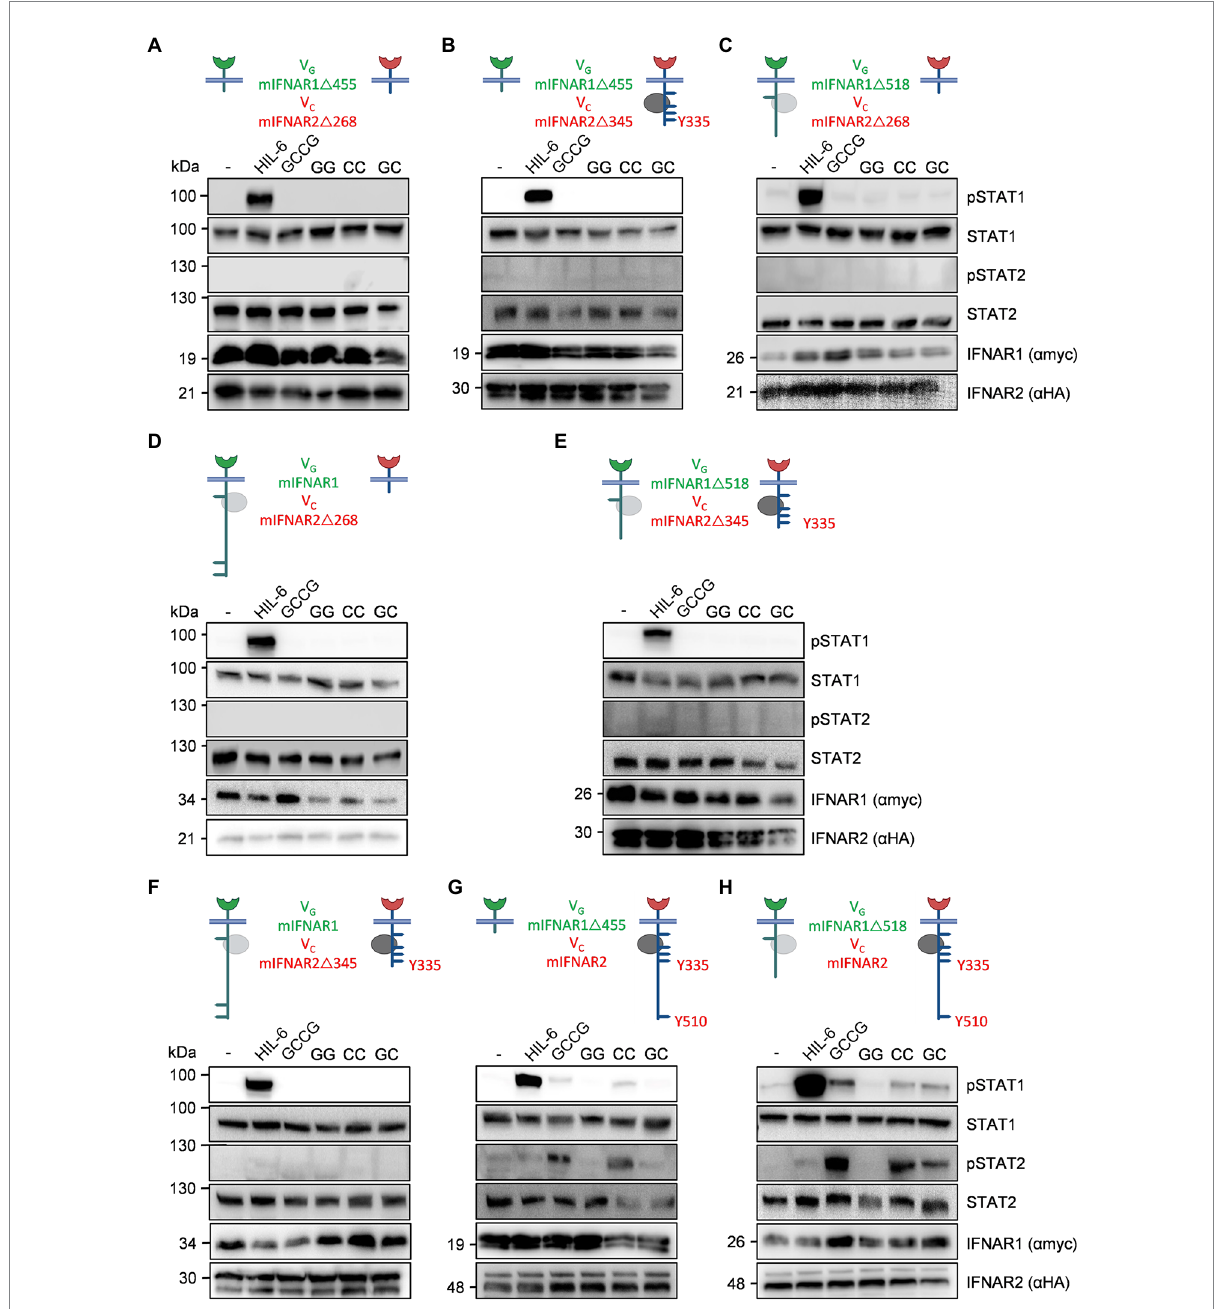
FIGURE 6 Deletion variants for synthetic murine IFNARs highlight the importance of Y510 in IFNAR2. The following murine receptor combinations were transiently transfected into HEK293 cells: (A) V G IFNAR1 Δ 455 and V C IFNAR2 Δ 268, (B) V G IFNAR1 Δ 455 and V C IFNAR2 Δ 345, (C) V G IFNAR1 Δ 518 and V C IFNAR2 Δ 268, (D) V G IFNAR1 and V C IFNAR2 Δ 268, (E) V G IFNAR1 Δ 518 and V C IFNAR2 Δ 345, (F) V G IFNAR1 and V C IFNAR2 Δ 345, (G) V G IFNAR1 Δ 455 and V C IFNAR2, and (H) V G IFNAR1 Δ 518 and V C IFNAR2. Conserved tyrosine residues between human and murine receptors are indicated. (A–H) STAT1 and STAT2 activation was determined in transiently transfected HEK293 cells treated with 10 ng/ml Hyper-IL-6, 100 ng/ml of the synthetic cytokine ligands (GCCG, GG, CC, GC) for 30 min. Equal amounts of proteins (50 μ g/lane) were analyzed via specific antibodies detecting phospho-STAT1, phospho- STAT2, STAT1, STAT2, IFNAR1 (myc-tagged), and IFNAR2 (HA-tagged). Western blot data shows one representative experiment out of